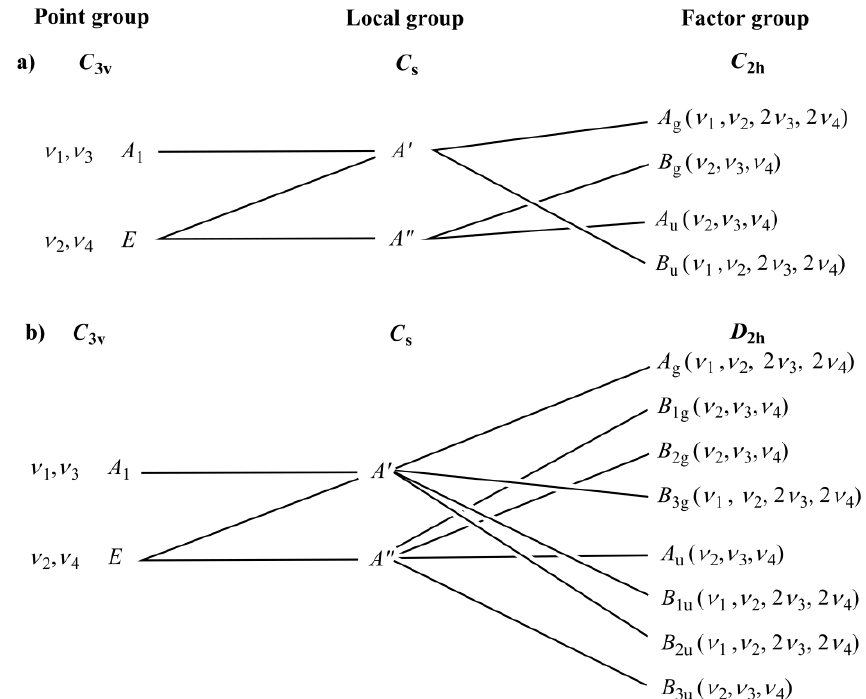
Figure 4. Correlation diagrams of ammonia ligand in ( a ) monoclinic ( 1-M ) and ( b ) orthorhombic ( 1-O ) polymorphs of [Ag(NH 3 ) 2 ]ClO 4 .